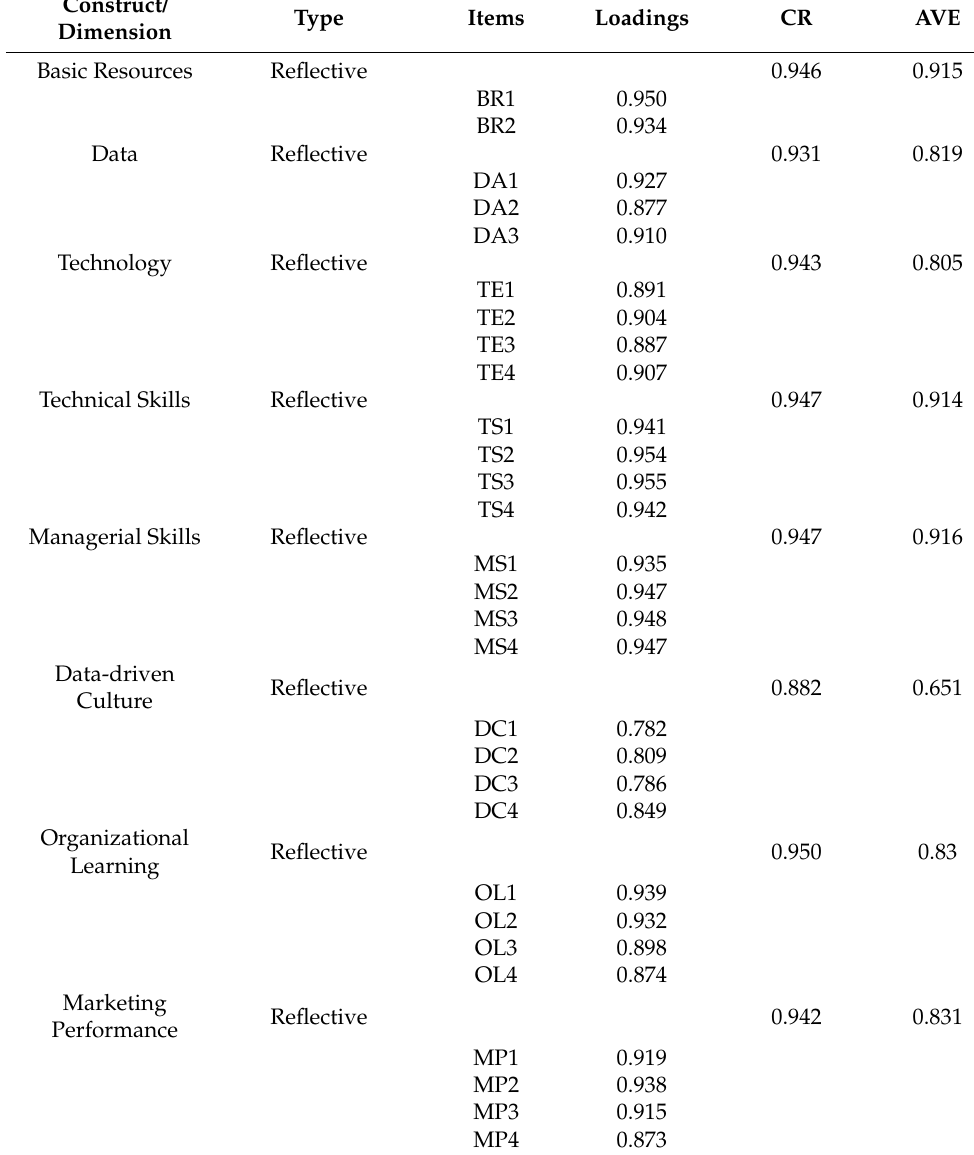
Table 1. Validation of the measurement